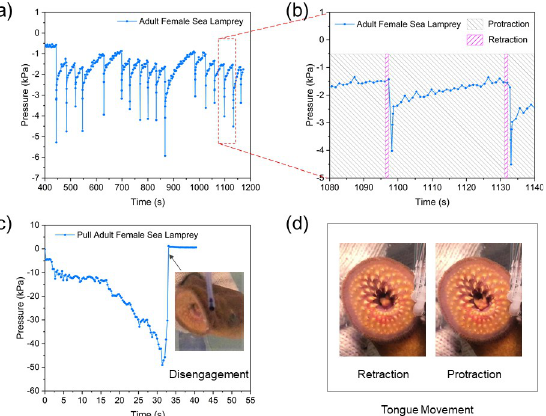
Fig 10. Suction dynamics of an adult female sea lamprey in Experiment 1. (a) Suction pressure when the adult female lamprey attached to the panel during 400 s to 1200 s after attachment, (b) suction pressure profile during 1080 s to 1140 s after attachment with shaded rectangles showing the time when the lamprey’s tongue was protracted or retracted, (c) suction pressure profile when the adult lamprey was pulled away from the panel with corresponding snapshot of the lamprey’s mouth disengaged from the panel, and (d) pictures of an adult lamprey’s mouth showing the protraction and retraction states of its tongue.